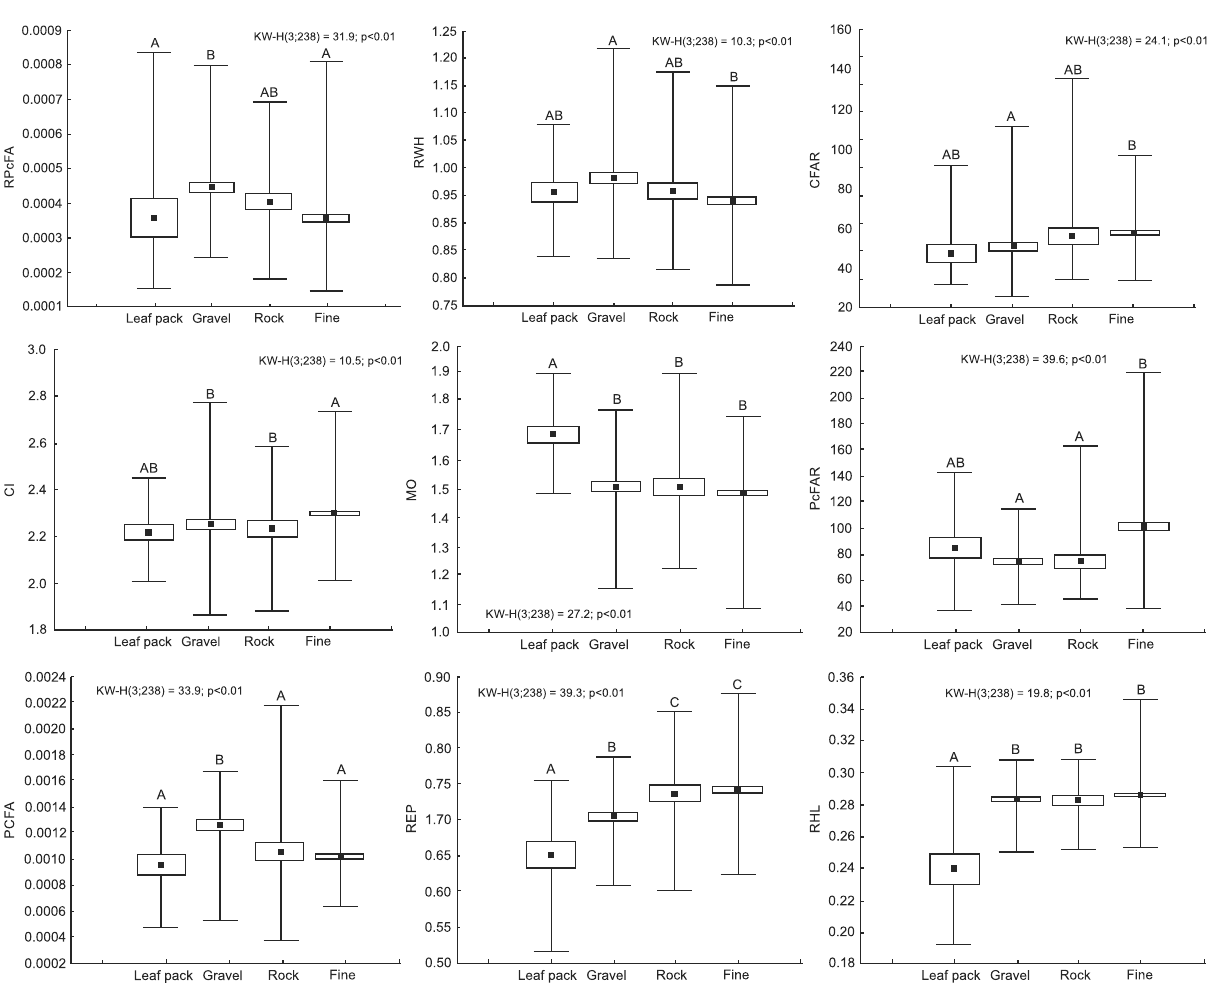
Figure 5. The means, standard deviations, and minimum and maximum values for the ecomorphological attributes of Astyanax rivularis present in streams with different substrates collected in Rio São Francisco streams in September 2010. CI (compression index), RHL (relative head length), RWH (relative width of head), RPE (relative eye position), CFAR (caudal fin aspect ratio), PcFAR (pectoral fin aspect ratio), RCFA (relative caudal fin area), RPcFA (relative pectoral fin area), MO (mouth